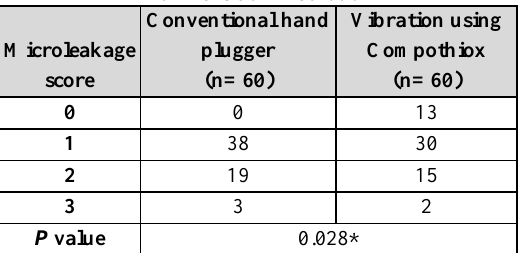
Table 1: Distribution of the overall microleakage scores of the conventional method compared to that of vibration method.